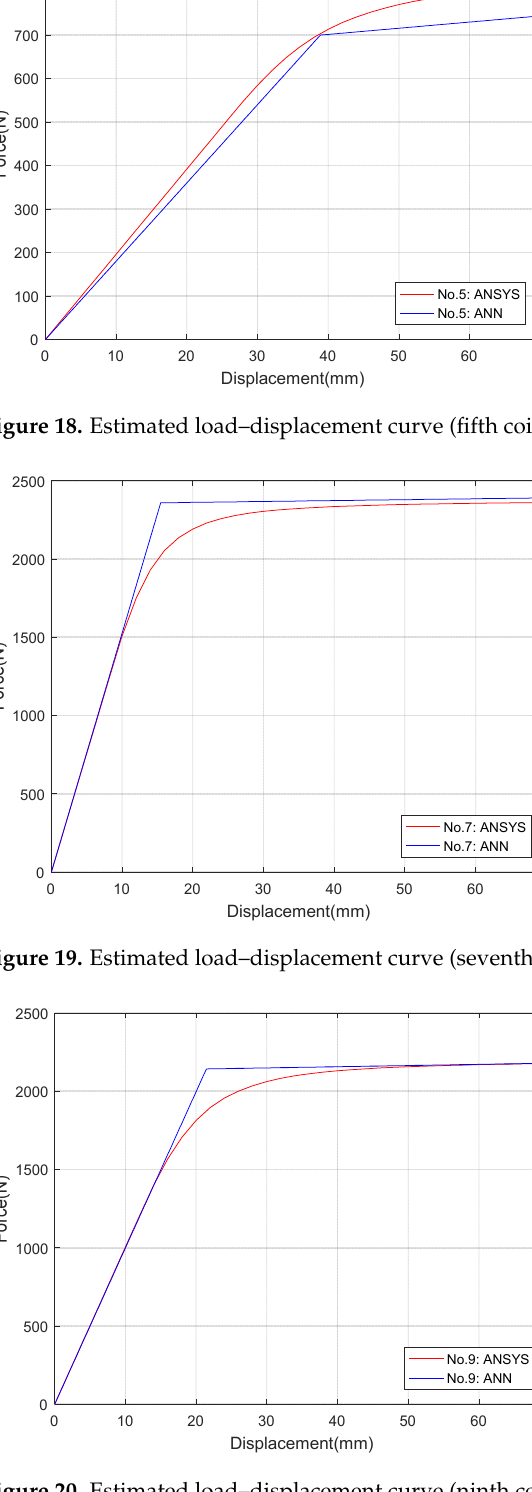
Figure 20. Estimated load–displacement curve (ninth coil damper).